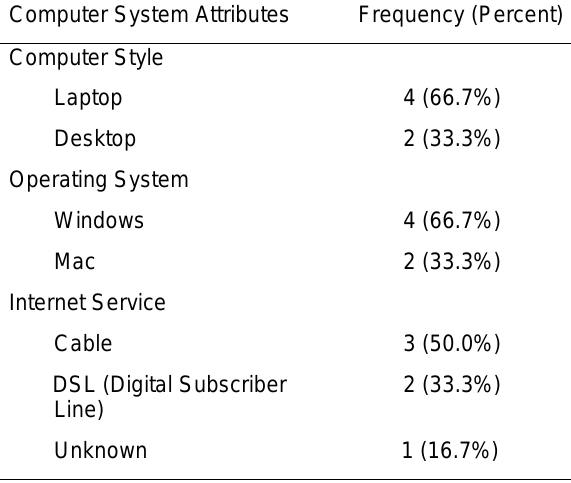
Table 1. Class Leader Computer System Set